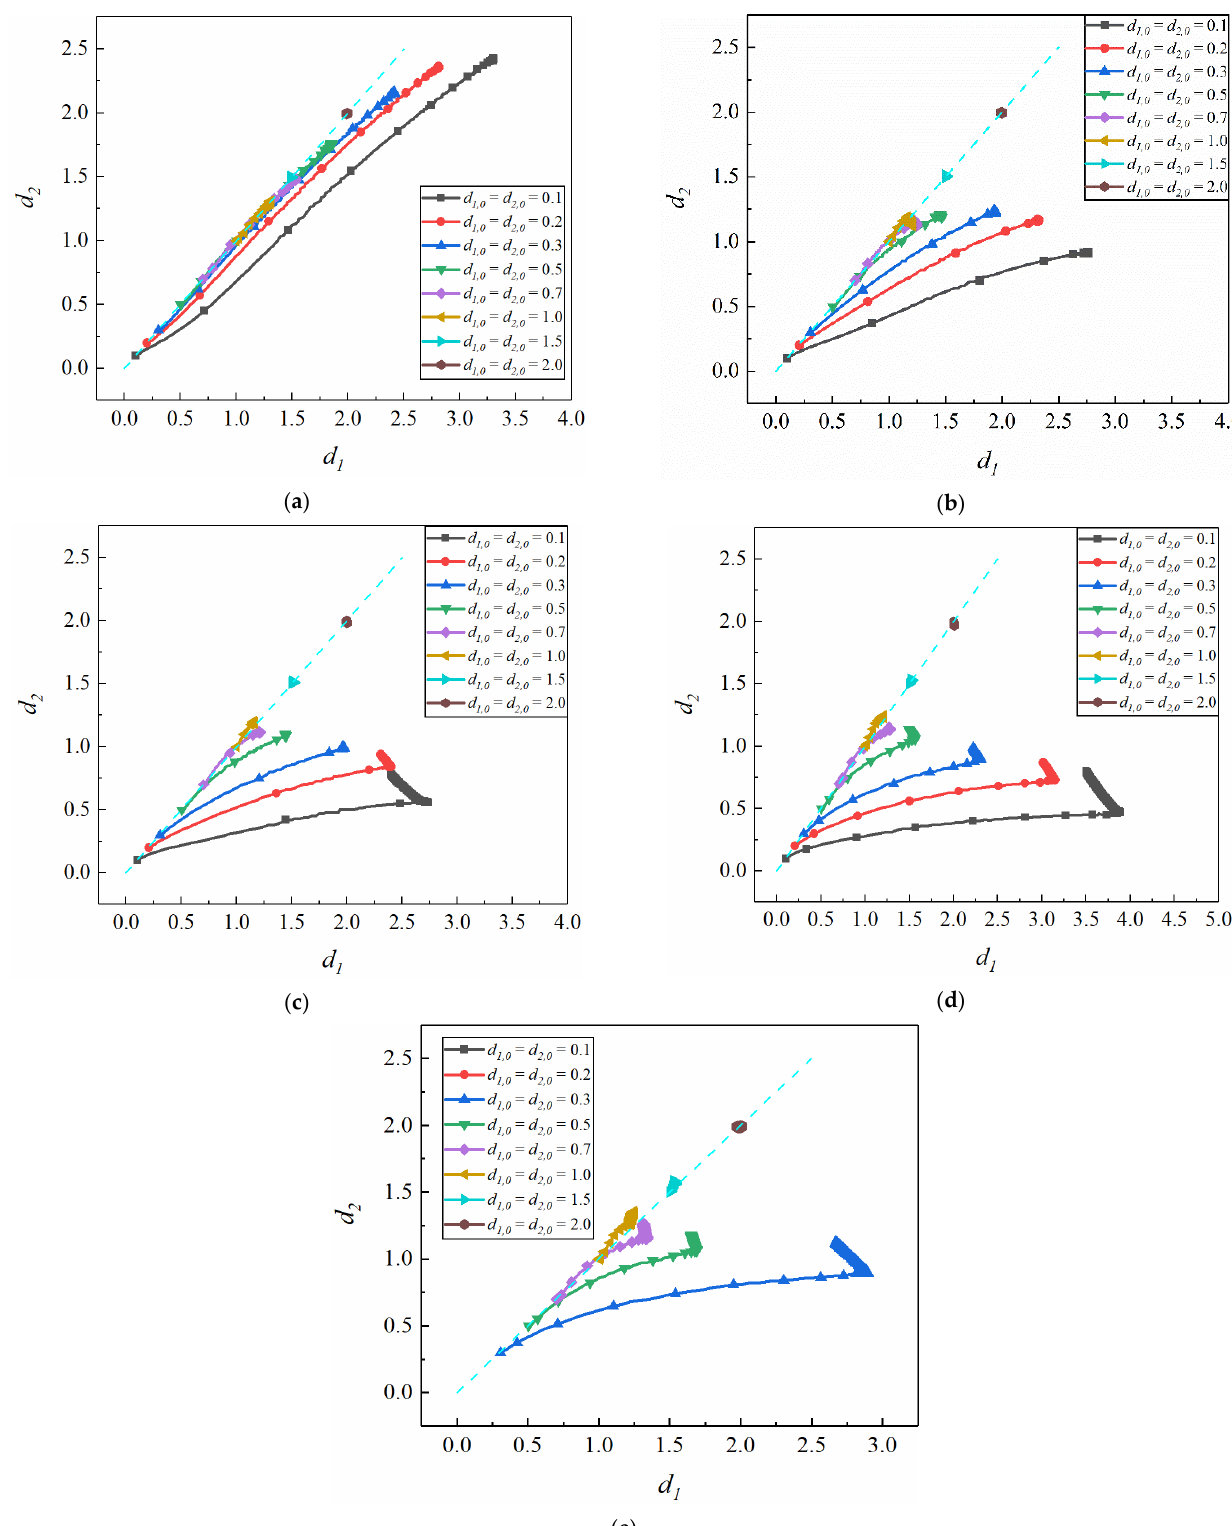
Figure 7. Diverse variations of interparticle distances for different initial interparticle distances and Wi. ( α = 0.1, η r = 0.3, ε = 0.3, y 0 = 0.2). ( a ) Wi = 0.1; ( b ) Wi = 0.3; ( c ) Wi = 0.5; ( d ) Wi = 1.0; ( e ) Wi = 1.5.